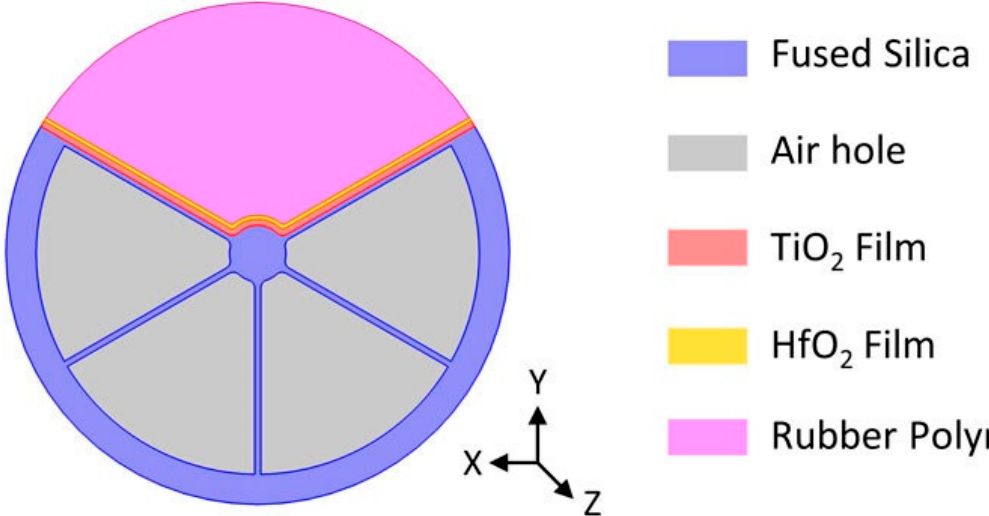
Figure 10. Cross-section of the grapefruit PCF structure proposed for the fabrication of a LMR-based pressure sensor. Reprinted from [54].